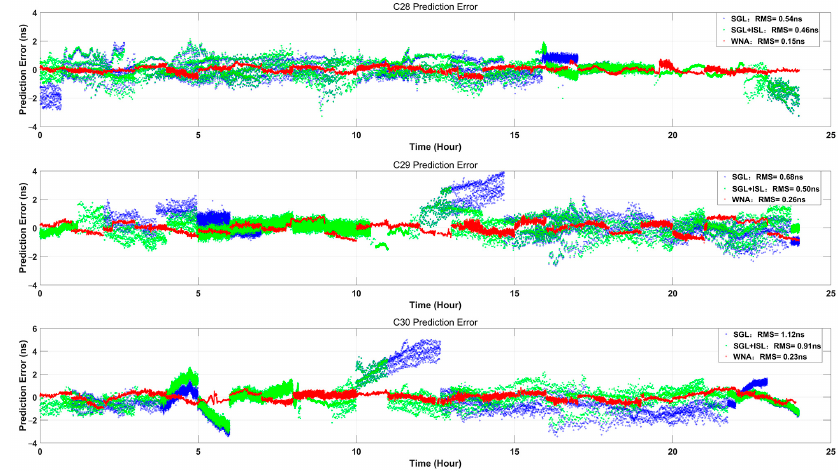
Figure 7. Prediction error.